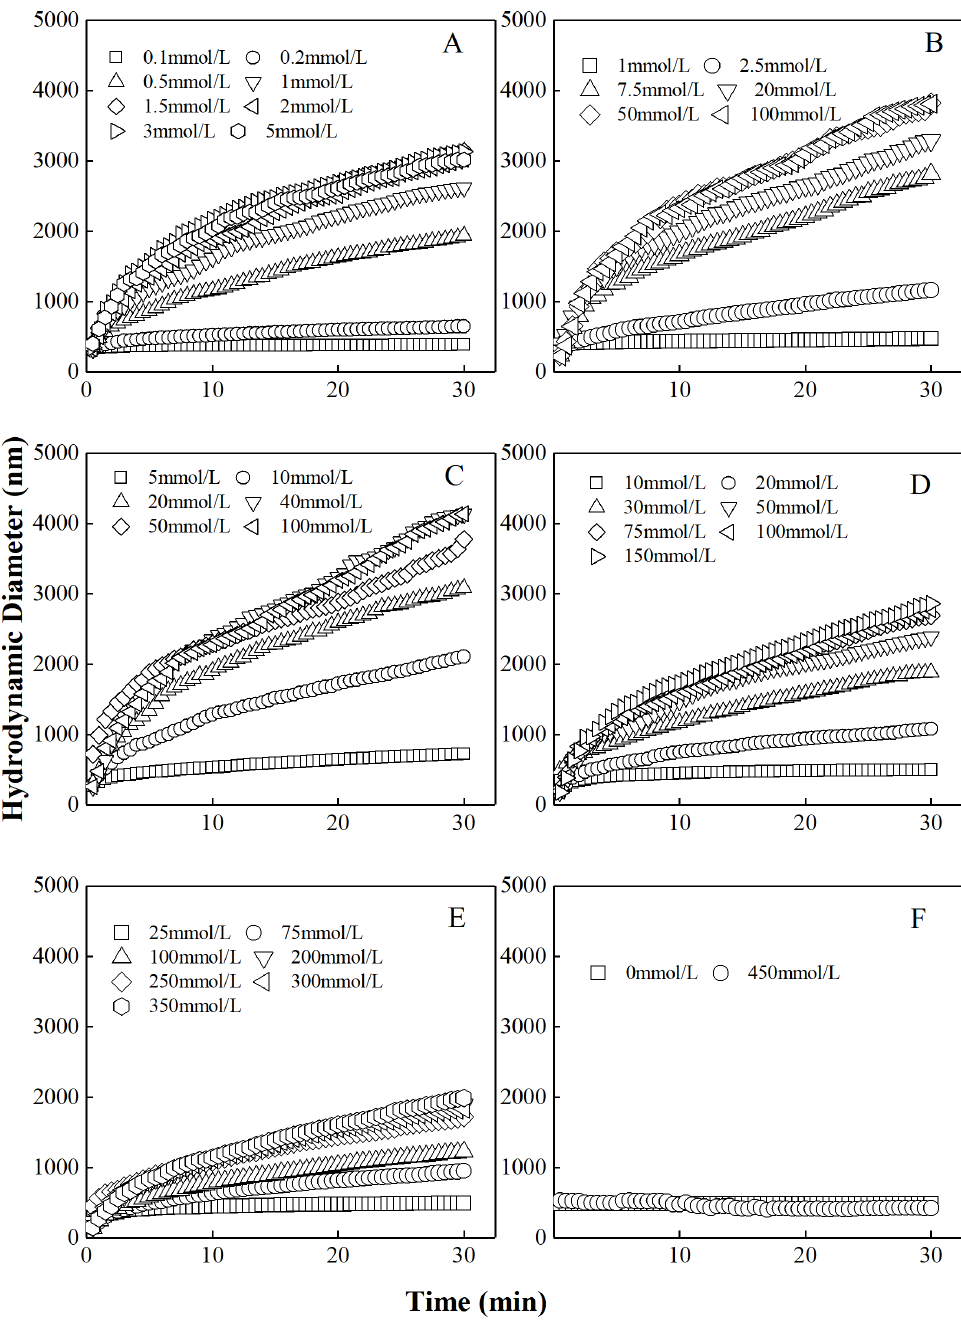
Figure 3 Growth of hydrodynamic diameters of ‘‘100%kaolinite (A), 96.67% kaolinite + 3.33% P. putida (B), 93.33% kaolinite +6.67% P. putida (C), 83.33% kaolinite + 16.67% P. putida (D), 66.67% kaolinite + 33.33% P. putida (E), 100% P. putida (F)" aggregates in CsNO 3 solutions. Full-size DOI: